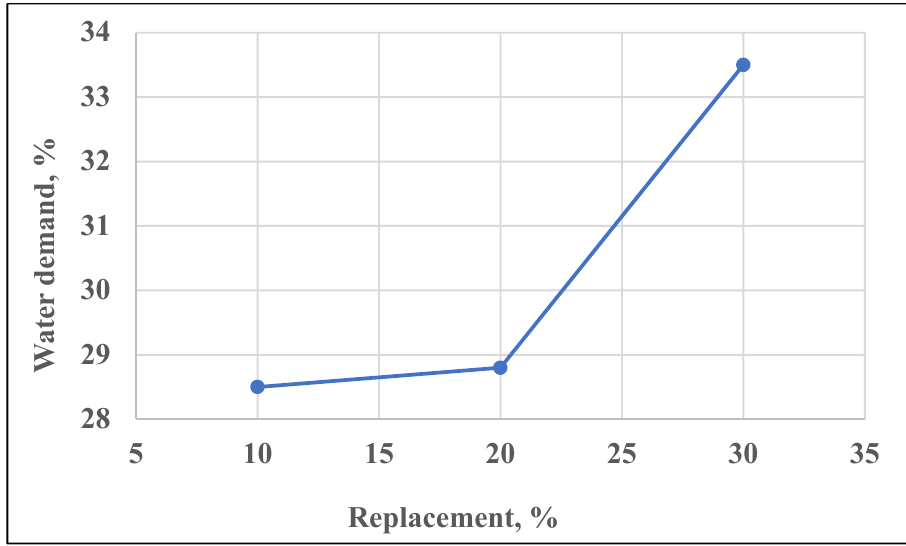
Figure 8. Water demand of calcined clay composite cement at different percentage replacements.